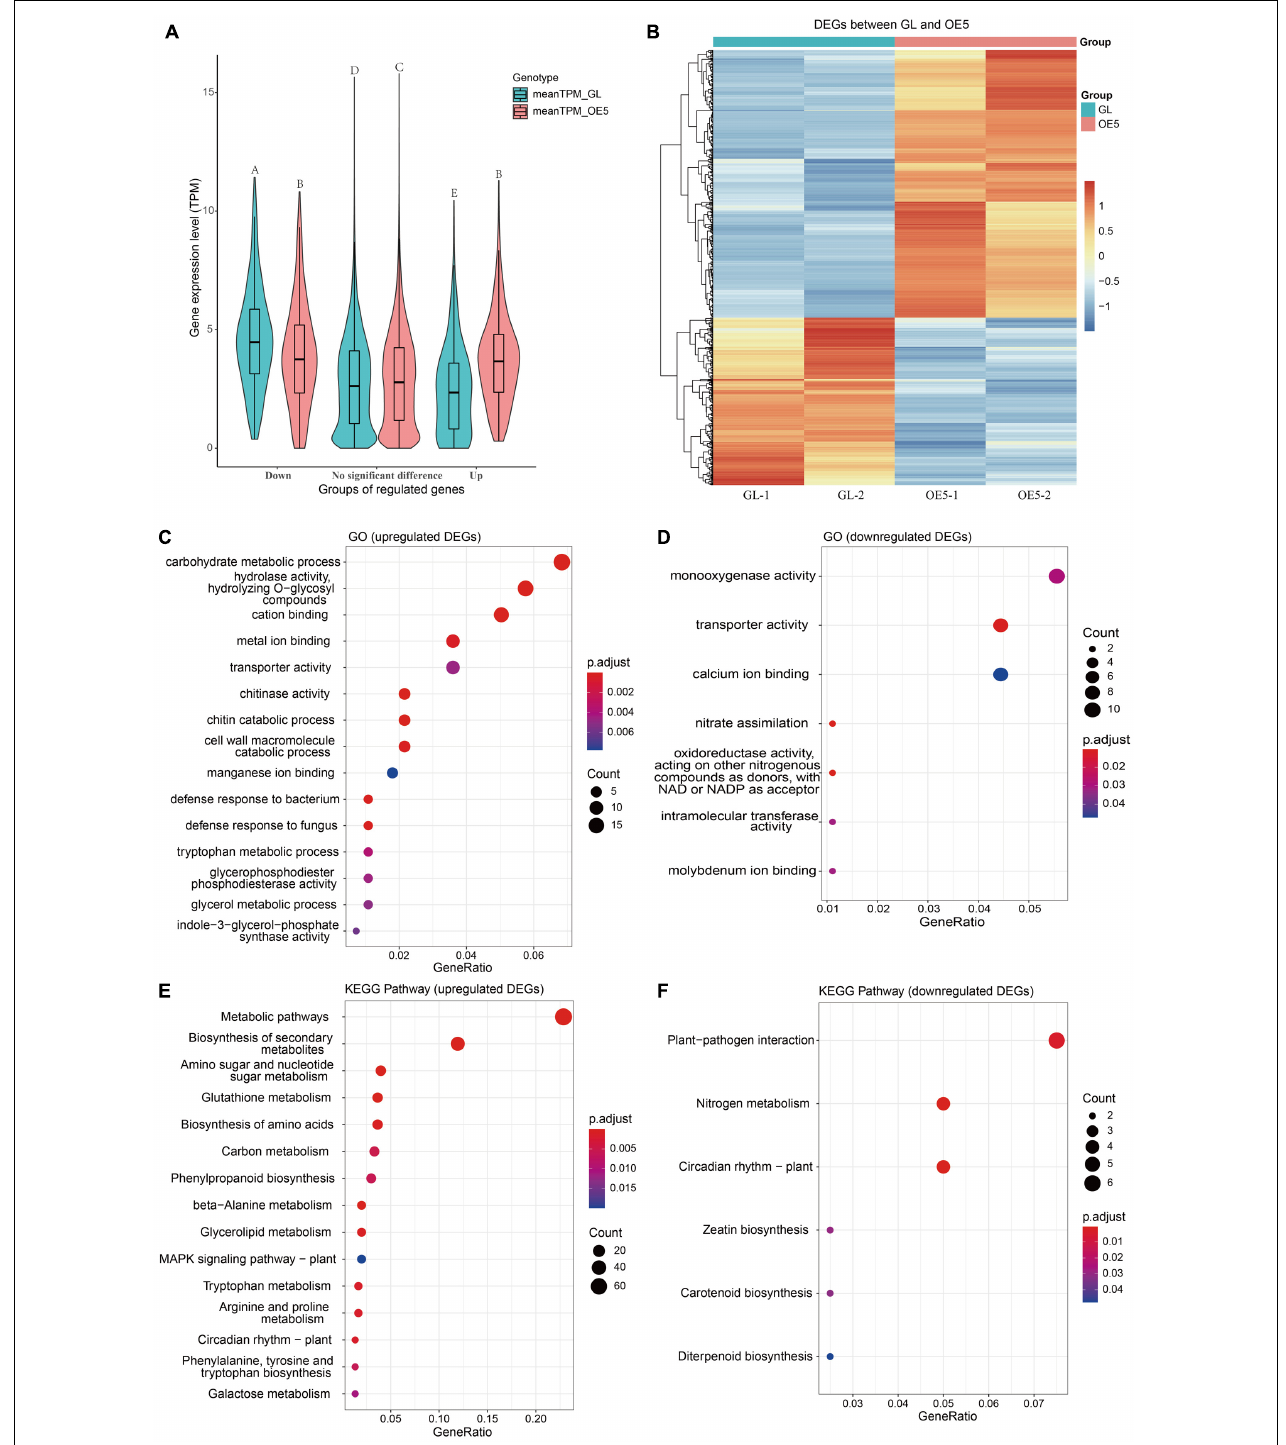
FIGURE 4 | Expression and functional enrichment of differentially expressed genes. (A) A comparison of mean expression levels of upregulated, no significant difference, and downregulated genes between GL and OE. Different letters above violin plots represent significant differences at P < 0.01 as revealed by one-way ANOVA analysis (Tukey’s multiple comparison test). (B) The heatmap of 457 upregulated and 286 downregulated DEGs. The TPM value of DEG was scaled by row with the “pheatmap” package in R. Dotplots of significant GO terms for upregulated (C) and downregulated (D) DEGs. Dotplots of significant KEGG pathways for upregulated (E) and downregulated (F) DEGs. GO terms and KEGG pathways with adjusted P -value < 0.05 were considered as significant, and if the number of significant terms or pathways was > 15, only 15 terms or pathways were plotted.